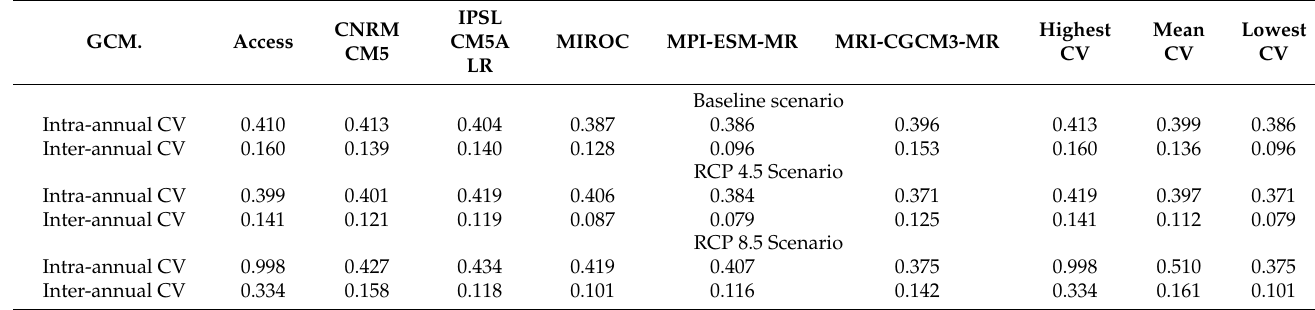
Table 1. Estimated coefficient of variation